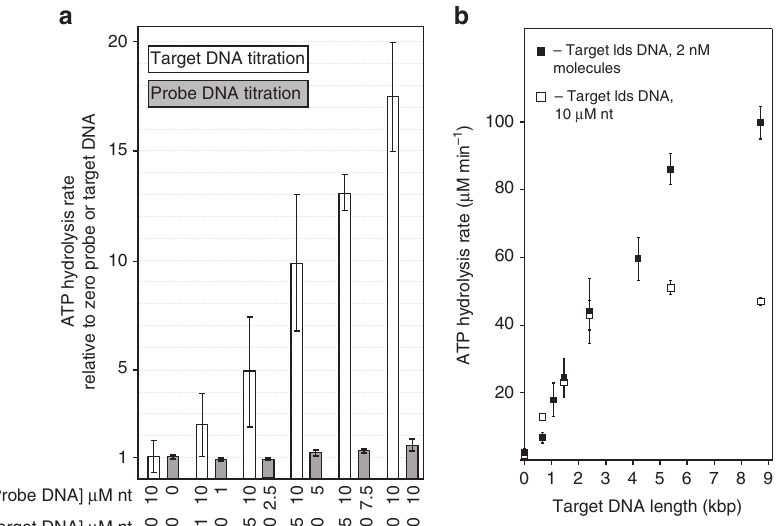
Figure 6 | The stimulation of RecN ATPase by RecA protein under D-loop assay conditions is target DNA concentration- and length-dependent. Reactions were carried out in Buffer A and assembled as in reaction 6, including protein concentrations, from Fig. 5b, except as noted. ( a ) The steady-state RecN ATP hydrolysis rate was measured when added to RecA K83R protein incubated with probe DNA (where indicated) followed by target DNA (where indicated). The probe DNA concentration is held constant at 10 m M and the target DNA concentration is titrated (0–10 m M), and white bars represent the rate of ATP hydrolysis catalysed by RecN protein at each DNA concentration relative to the rate measured at zero target DNA. The target DNA concentration is held constant at 10 m M and the probe DNA concentration is titrated (0–10 m M), and grey bars represent the rate of ATP hydrolysis catalysed by RecN protein at each DNA concentration relative to the rate measured at zero probe DNA. Error bars represent the s.d. of the relative rate (the s.d. of the average rate divided by the average rate) from 3 to 15 independent experiments (see Table 2 for steady-state rates). ( b ) The steady-state RecN ATP hydrolysis rate was measured when added to RecA K83R protein incubated with 2nM molecules (10 m Mnt) probe DNA followed by 2nM molecules linearized, target DNA (target lds DNA, black square) or 10 m M of nucleotides linearized, target DNA (target lds DNA, white square) of different lengths, as indicated. The linear duplex target DNA substrate length in kilobase pairs (kbp) and concentration in m Mnt and nM molecules for the two sets are as follows: 0.65kbp (2.6 m M, black square; 7.7nM, white square); 1.1kbp (4.3 m M, black square); 1.5kbp (5.8 m M, black square; 3.5nM, white square); 2.4kbp (9.6 m M, black square; 2.1nM, white square); 4.2kbp (16.8 m M, black square); 5.4bp (21.5 m M, black square; 0.9nM, white square); and 8.7kbp (34.8 m M, black square; 0.6nM, white square). The error bars represent the s.d. of four independent experiments. nt,